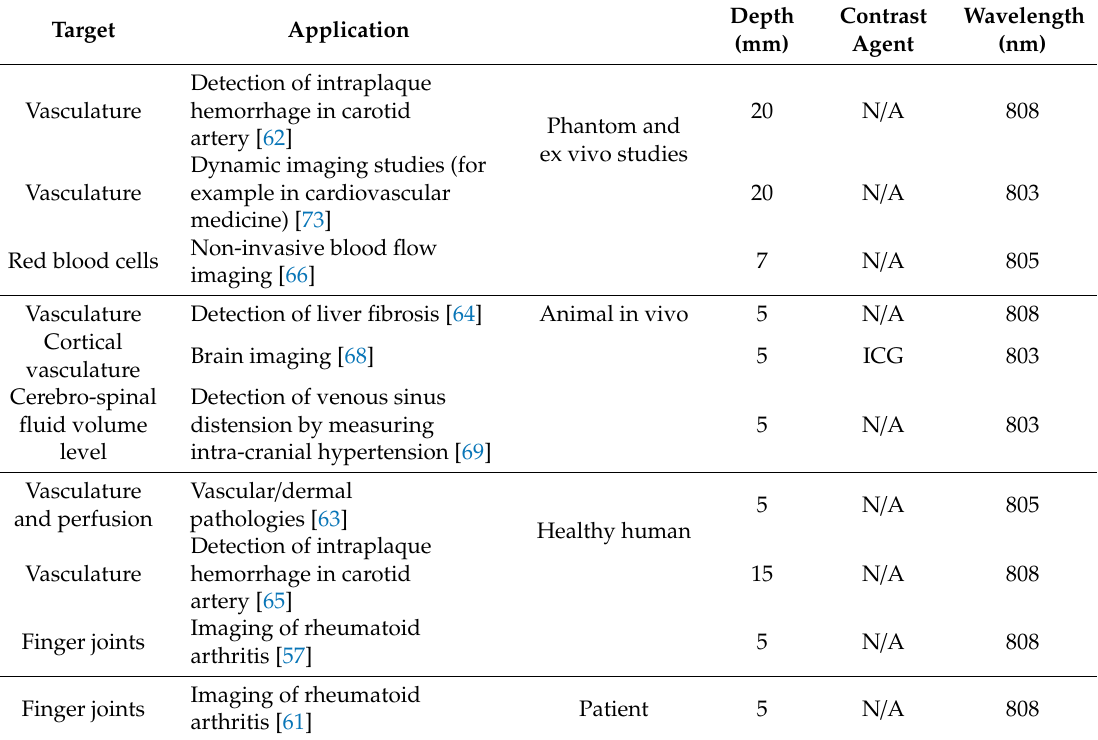
Table 5. Summary of the preclinical and clinical applications of LD-based PAI. ICG, indocyanine